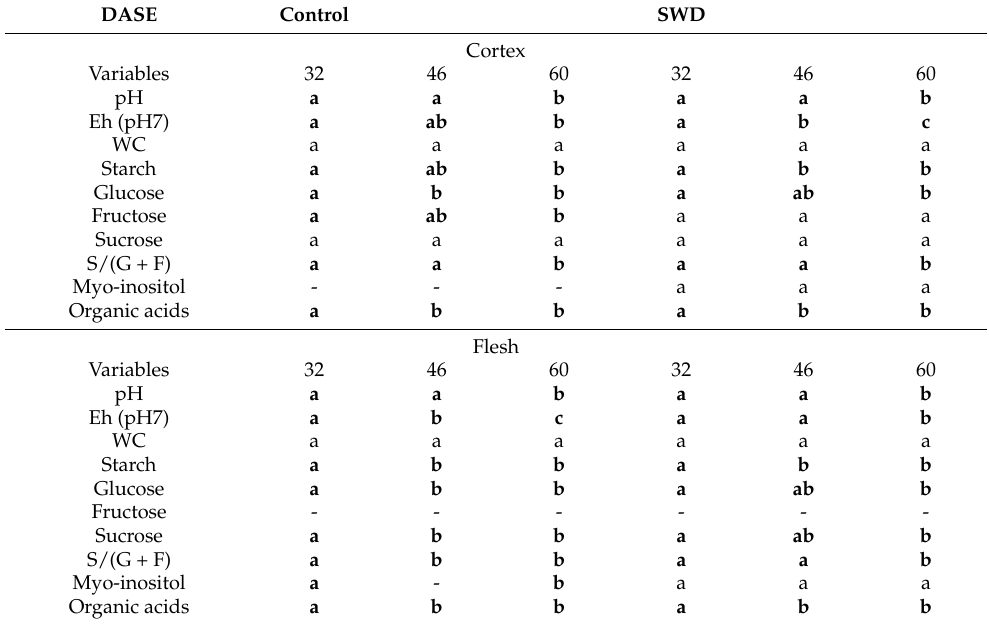
Table 3. Statistical evaluation of the effect of growth phase on biochemical parameters (ANOVA test followed by the Tukey HSD test, or the Kruskal–Wallis test followed by the Bonferroni test; Statgraphics, alpha = 5%). Different letters between 32, 46 and 60 DASE for the same growth condition indicate a statistically significant